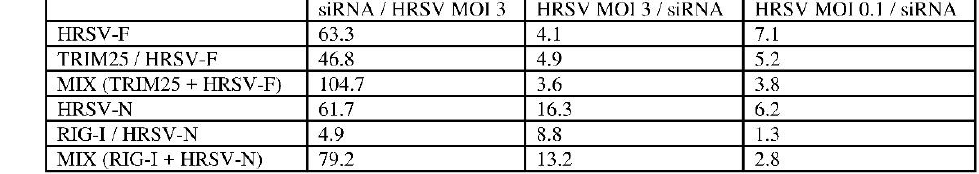
Figure 2. Human respiratory syncytial virus titers in the supernatant of infected cells transfected with the different siRNAs (upper panel: control, TRIM25, HRSV-F, TRIM25/HRSV-F or a combination of TRIM25 and HRSV-F (MIX); lower panel: control, RIG-I, HRSV-N, RIG-I / HRSV-N or a combination of RIG-I and HRSV-N (MIX)). Cells were transfected with the siRNAs before or after virus infection and the supernatant was collected at 24 and 48 h post infection (hpi). Small interfering RNA / HRSV multiplycity of infection (MOI) 3 (siRNA / HRSV MOI 3): infection was carried out at 24 h post-transfection at an MOI of 3. Human respiratory syncytial virus MOI 3 / siRNA (HRSV MOI 3 / siRNA): cells were infected at an MOI of 3 and then transfected eight hours later. Human respiratory syncytial virus MOI 0.1 / siRNA (HRSV MOI 0.1 / siRNA): infection was done at an MOI of 0.1 and transfection was carried out eight hours later. Data represent the mean and standard deviation from three independent experiments. Comparisons between groups were done by the t -test: *, p < 0.05 and **, p < 0.01. For 48 hpi, the decrease in the virus titer (fold over control) for each siRNA and condition is shown in the table below the